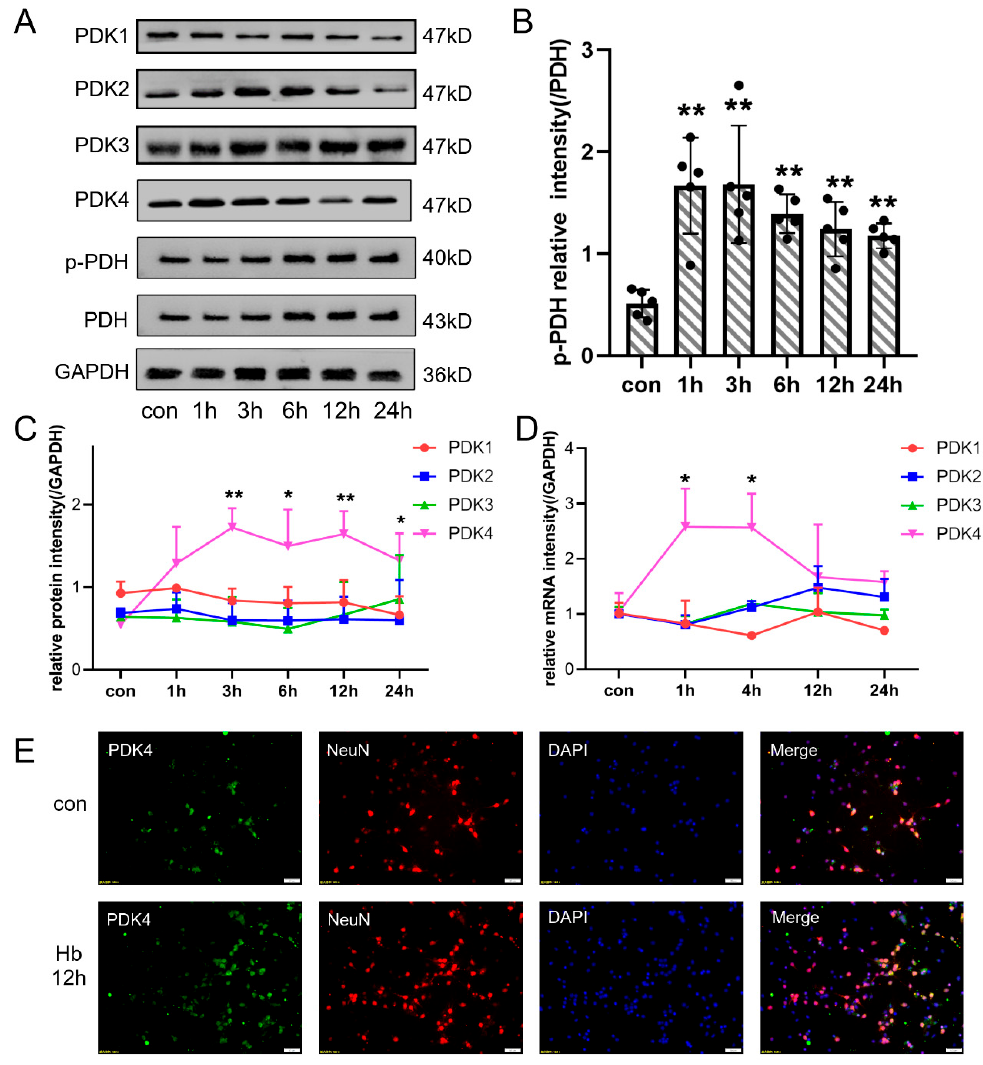
Figure 4. The expression of PDKs in cultured primary neurons after Hb stimulation. ( A ) Representa- tive bands of PDK1, PDK2, PDK3, PDK4, PDH, and p-PDH expression at each time point (0, 1, 3, 6, 12, and 24 h) after Hb stimulation. ( B ) Quantitative analysis of Western blot results showed that the ratio of p-PDH/PDH was significantly increased after Hb stimulation. ( C , D ) Quantitative analysis of Western blot and qPCR results showed that variation of PDKs protein at each time point (0, 1, 3, 6, 12, and 24 h) and mRNA at each time point (0, 1, 4, 12, and 24 h) levels after Hb stimulation. ( E ) Representative immunofluorescence staining for PDK4 and NeuN (a neuronal marker) in cultured primary neurons after Hb stimulation (PDK4, green; NeuN, red; DAPI, blue). Bars represent the means ± SD. * p < 0.05; ** p < 0.01 vs. con ( n = 5 in each group). Bar = 50 µ